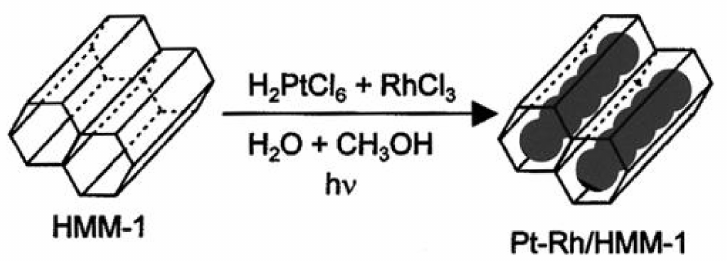
Figure 11. Typical synthesis of metal nanowires inside the channels of HMM-1. Reprinted with permission from Reference [104]. Copyright (2001) American Chemical